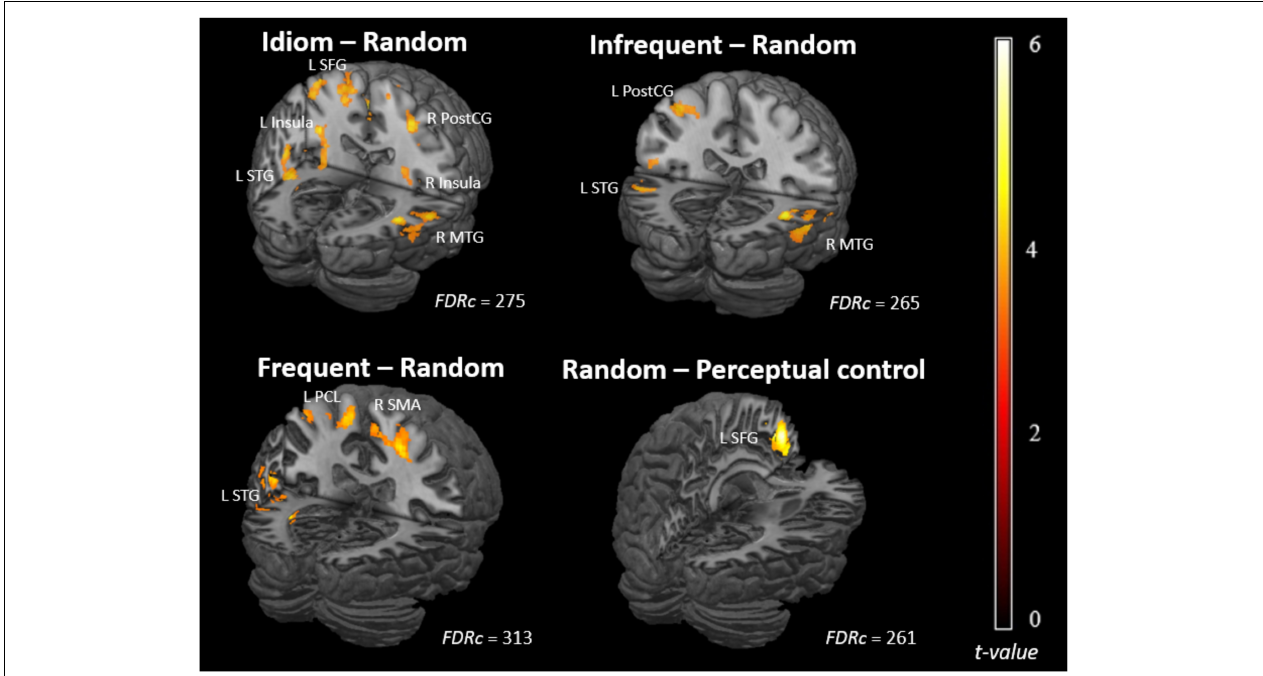
FIGURE 3 | Whole-brain statistical contrast maps overlaid on 3D rendered template brains. Contrast maps depict brain areas in which the contrast responses for older adults were higher than those for younger adults. Voxel-wise statistical significance was set at cluster-wise corrected q < 0.05 False Discovery Rate (FDR). L, left; R, right; FDRc, FDR-corrected cluster threshold; SFG, superior frontal gyrus; STG, superior temporal gyrus; MTG, middle temporal gyrus; SMA, supplementary motor area; PostCG, postcentral gyrus; PCL, paracentral lobule.